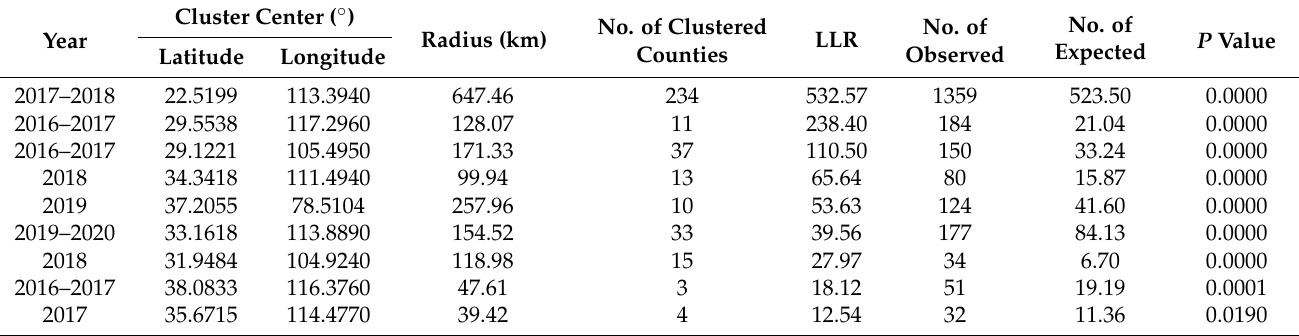
Figure 5. Space–time scanning analysis of Enterobius vermicularis infection among children in China from 2016 to 2020. Table 5. Cluster analysis of Enterobius vermicularis infection among children in China from 2016 to 2020 by spatial and space–time scan